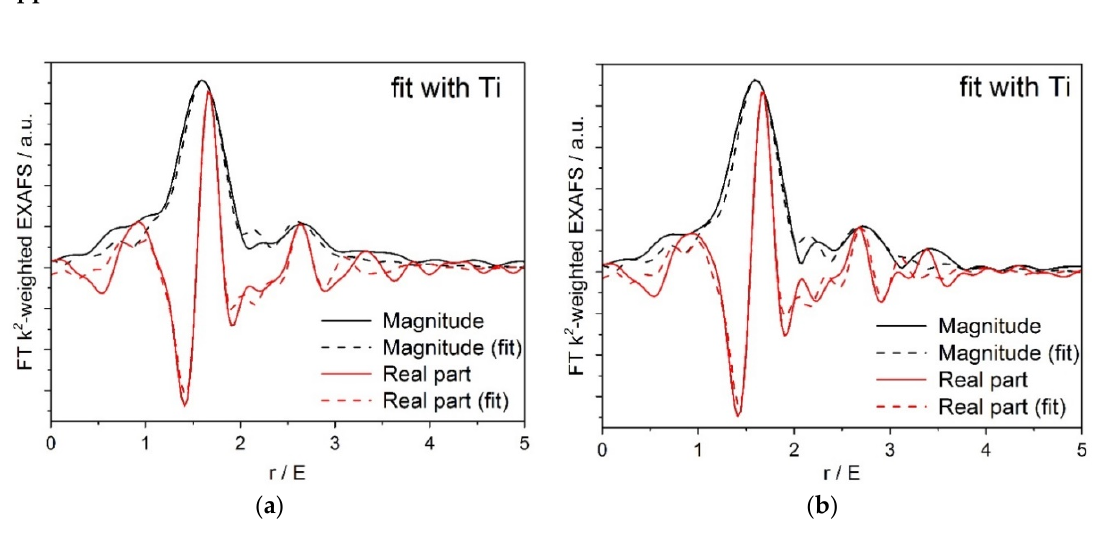
Figure A1. ( a ) Pt/Ti-P25-400 EXAFS fit to a structural model containing O and Ti nearest neighbors; ( b ) Pt/Ti-PLA-400 EXAFS fit to a structural model containing O and Ti nearest neighbors.